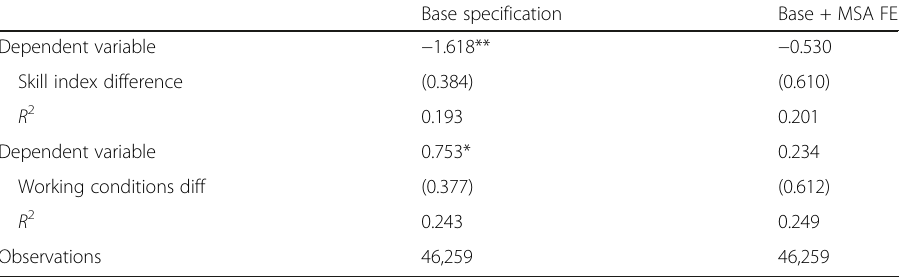
Table 9 Unemployment effect on primary minus secondary job differences in skills and working